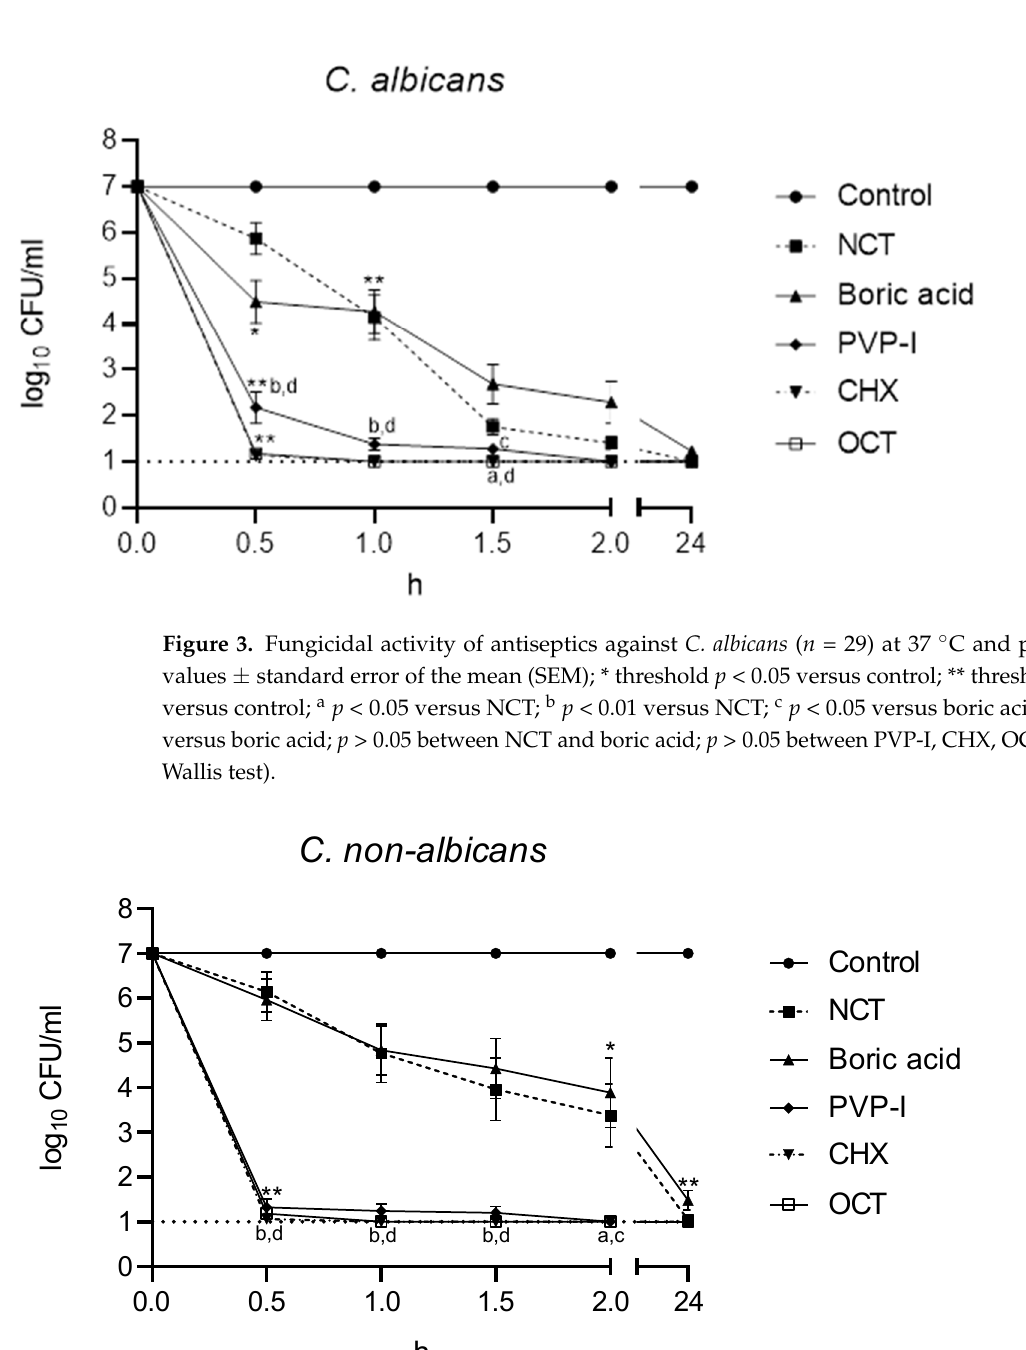
Figure 4. Fungicidal activity of antiseptics against C. non-albicans (n = 15) at 37 °C and pH 7. Mean values ± standard error of the mean (SEM); * threshold p < 0.05 versus control; ** threshold p < 0.01 versus control; a p < 0.05 versus NCT; b p < 0.01 versus NCT; c p < 0.05 versus boric acid; d p < 0.01 versus boric acid; p > 0.05 between NCT and boric acid; p > 0.05 between PVP-I, CHX, OCT (Kruskal– Wallis test).